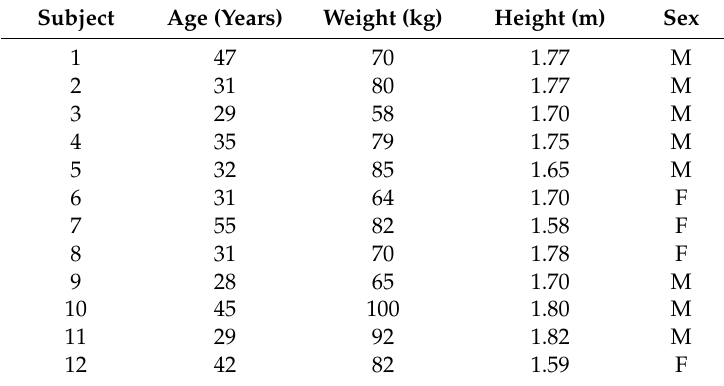
Table 1. Characteristics of the subjects included in the study, n =